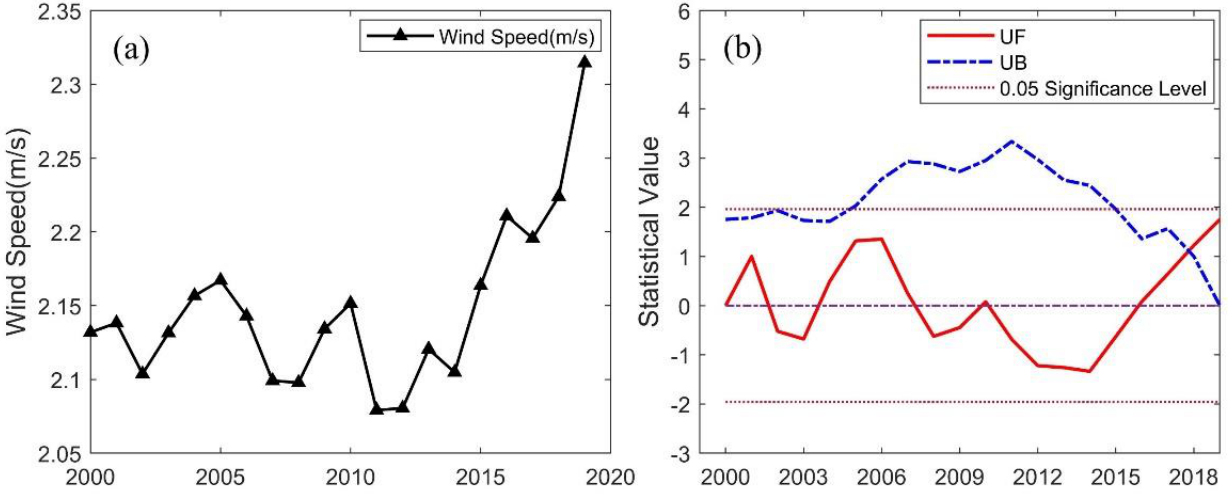
Figure 2. ( a ) Changes in China’s annual mean wind speed from 2000 to 2019; ( b ) statistical curve of the M-K trend and abrupt test of annual mean wind speed in China from 2000 to 2019.